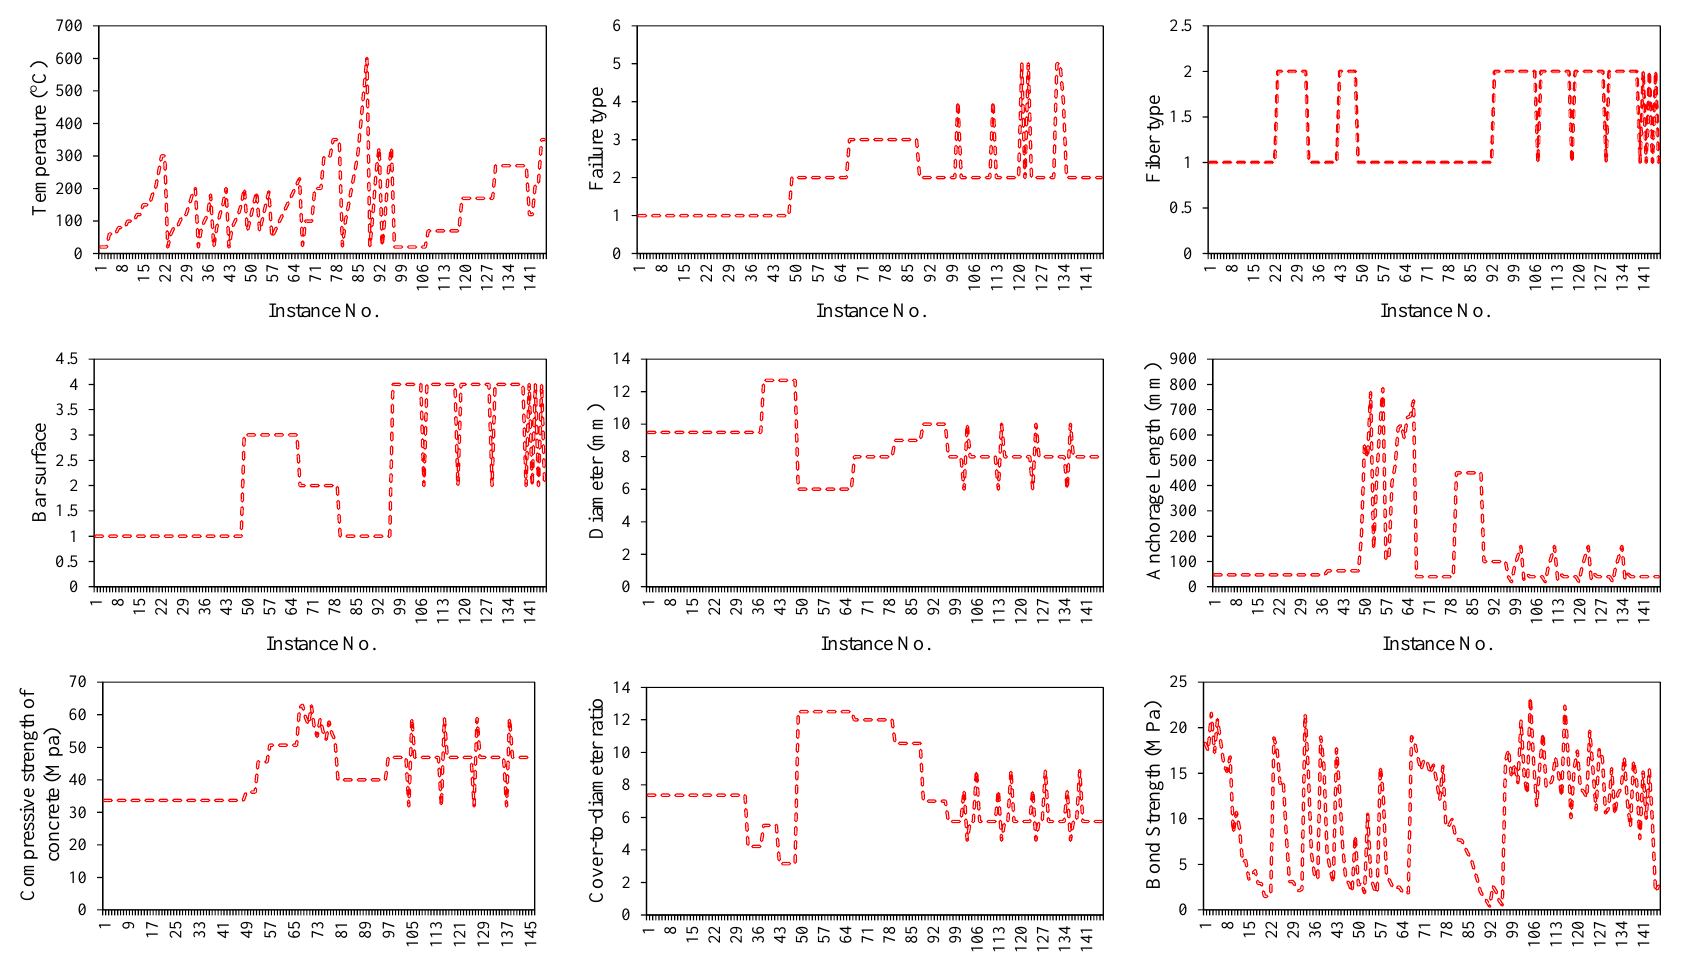
Figure 1. Input data used in the development of models.